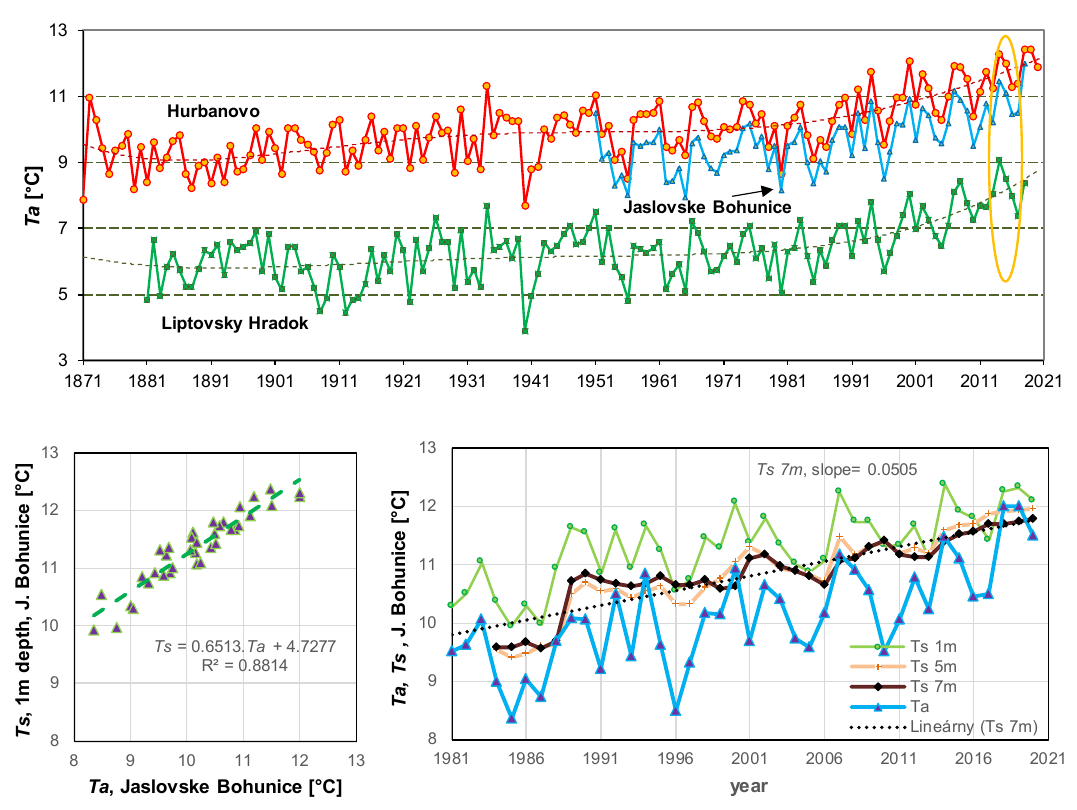
Figure 4. Mean annual air temperature ( Ta ) at the Hurbanovo (1871–2020), Liptovský Hrádok (1881–2018), and Jaslovské Bohunice (1951–2018) stations with polynomial long-term trends (dashed lines). Relationship between the Ta at Jaslovské Bohunice and Ts at 1m depth at Jaslovské Bohunice (bottom left). Mean annual air temperature at Jaslovské Bohunice (1981–2020) and mean annual temperatures at 1m, 5m, and 7m depth at Jaslovské Bohunice meteorological station (1984–2020) with the linear long-term trend +0.05 °C per year (bottom right).